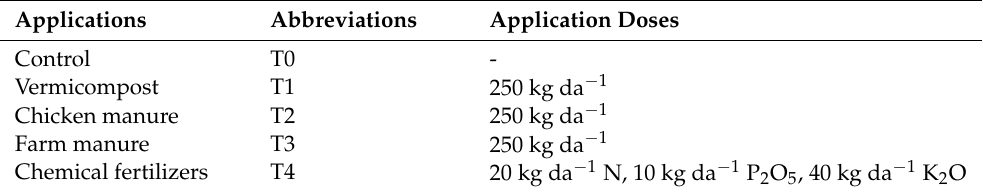
Table 3. Applications, abbreviations, and application doses used in the